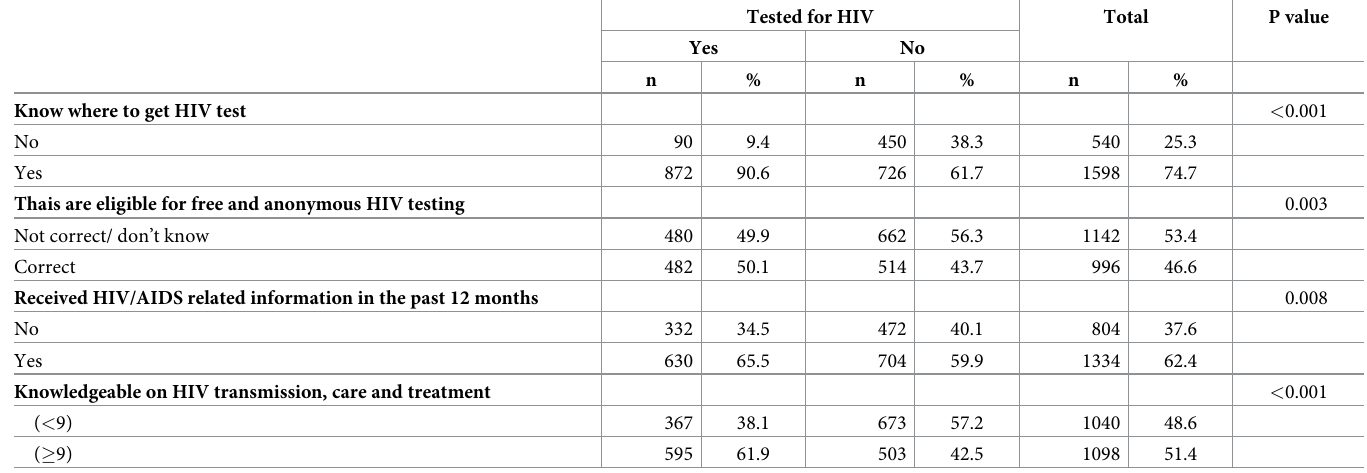
HIV. There was no difference between male and female respondents in terms of HIV